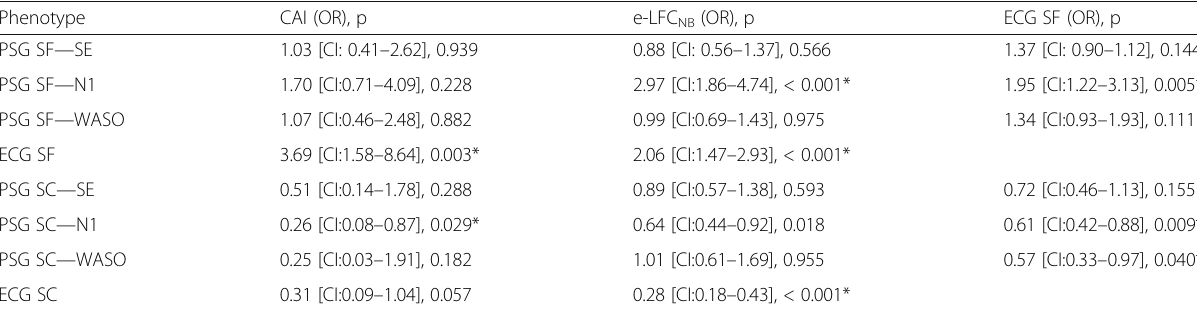
Table 9 Predictors of Primary